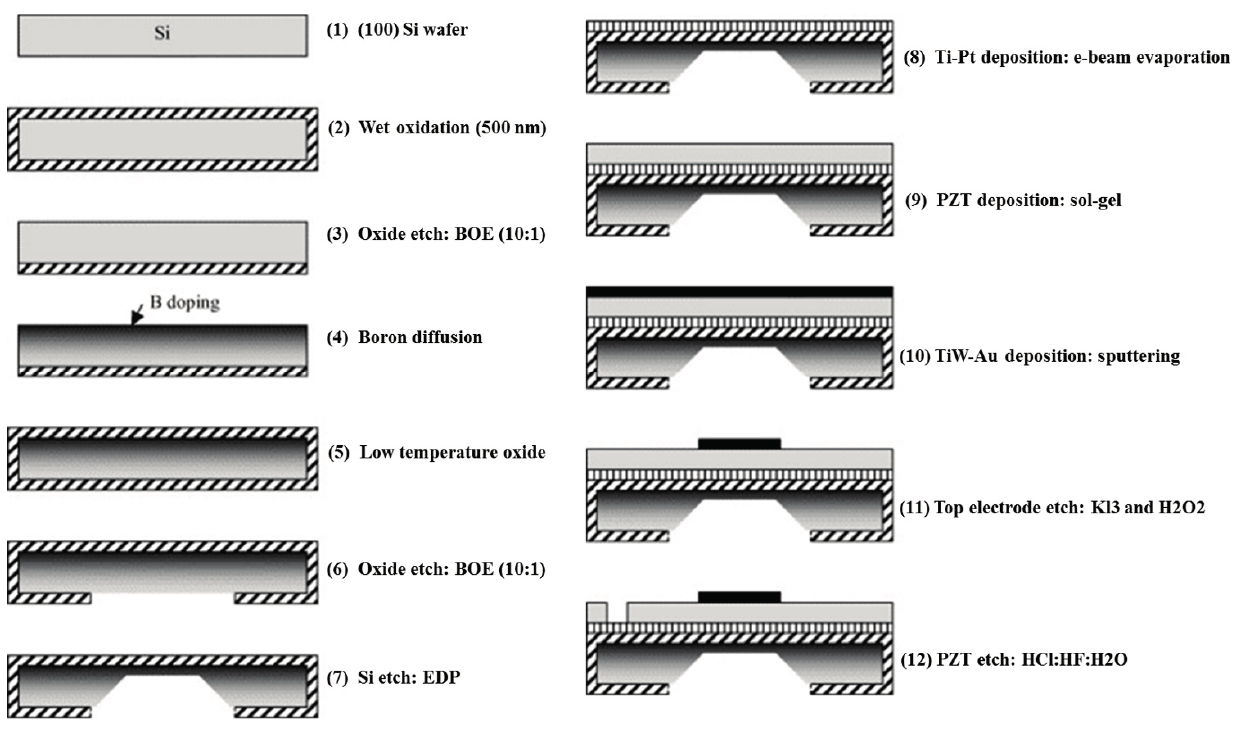
Figure 4. Fabrication process flow of PMUT element with diaphragm defined by back-side etching © 2004 Elsevier B.V. Reprinted with permission from [30].